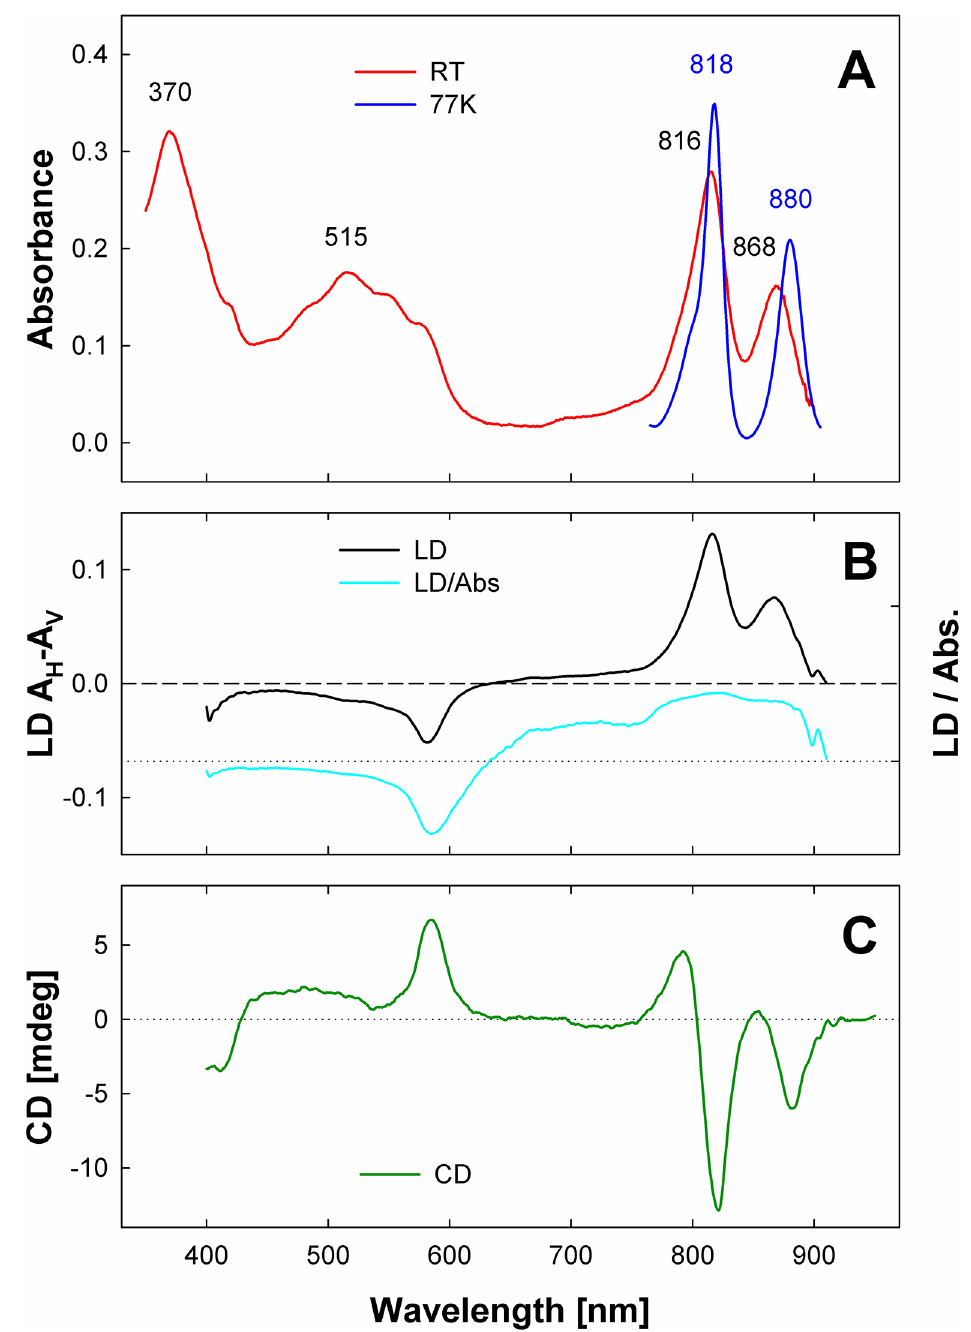
Fig 2. Steady-state spectraof purified PS complexes from G . phototrophica . (A) Absorptionspectra recordedat room temperature (red line) and at 77 K (blue line). (B) The thick line shows the LD ( LD = A H — A V ) spectra of the PS complex embedded in polyacrylamide gel. A H and A V correspond to absorbance of horizontally and vertically polarizedlight, respectively. For a flat, disk-likeparticlein a vertically compressed gel, the horizontaldirectionis parallelwith the particle plane,vertical with particle normal. The thin line shows the reducedLD, LD / Abs ., where Abs . is isotropicabsorbance. (C) Circular dichroism spectrum of PS complexes in solution. All dichroicspectra were measuredat room temperature. Abs, absorbance;CD, circulardichroism;LD, linear dichroism;mdeg, millidegree;PS, photosynthetic; RT, room temperature.